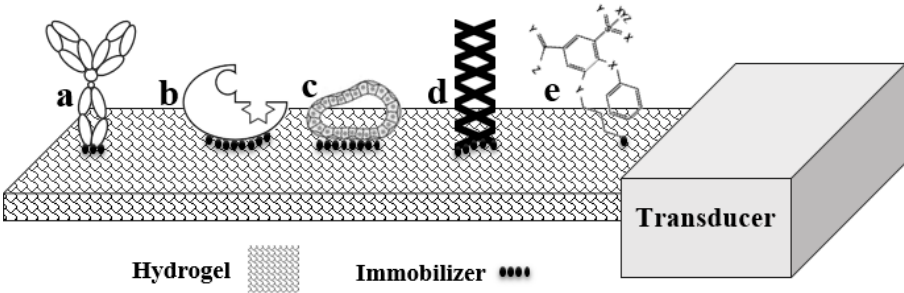
Figure 2. Schematic diagram of five distinct bioreceptor categories ( a ) antigen/antibodies; ( b ) enzymes; ( c ) cells and cellular structures; ( d ) nucleic acids and DNA; and ( e ) biomimetic.